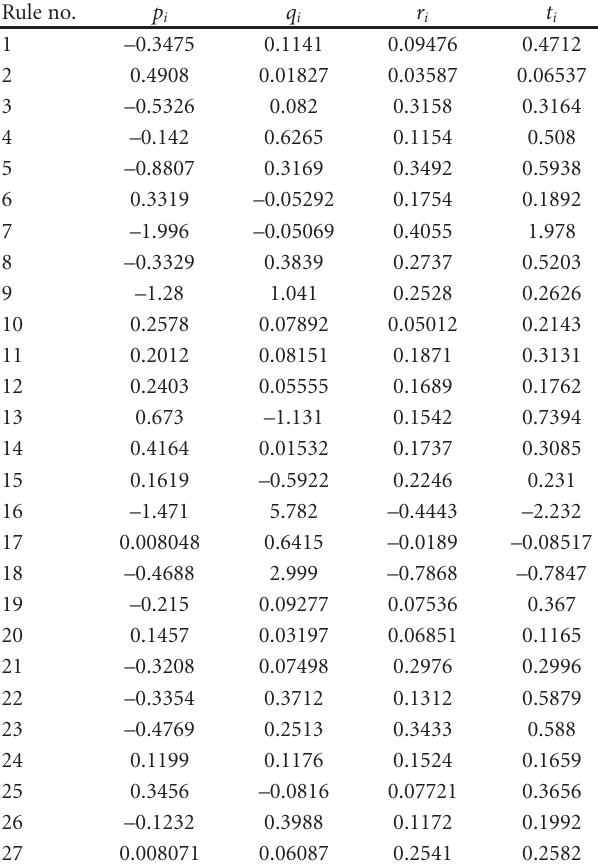
Table 9: The consequent parameters of ANFIS FO Sugeno model trained with HL algorithm.